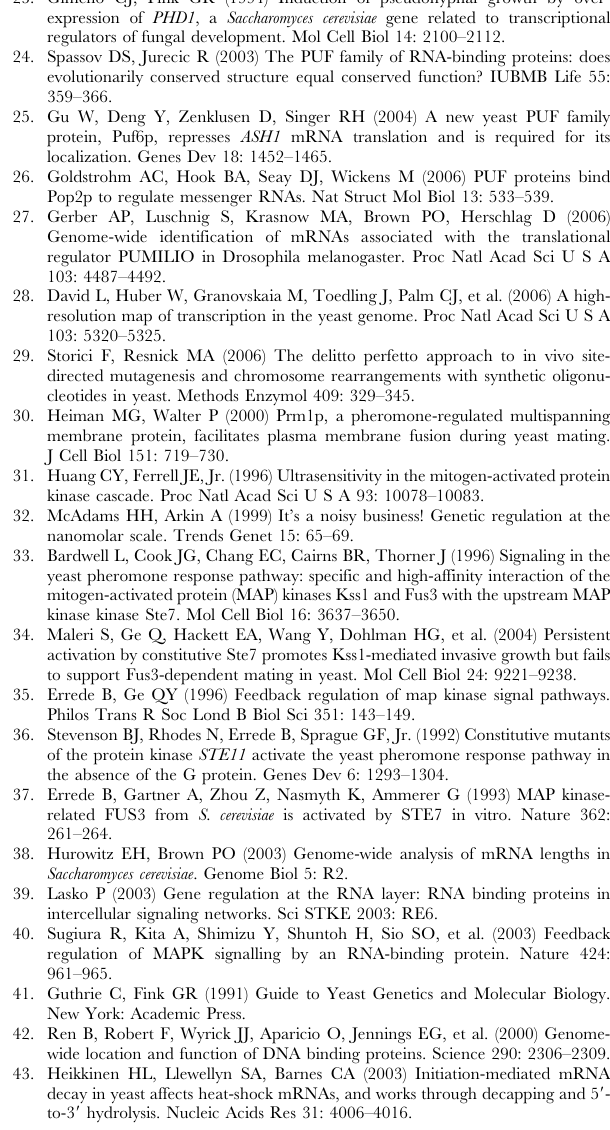
Figure S3 fMAPK and mMAPK pathway output in